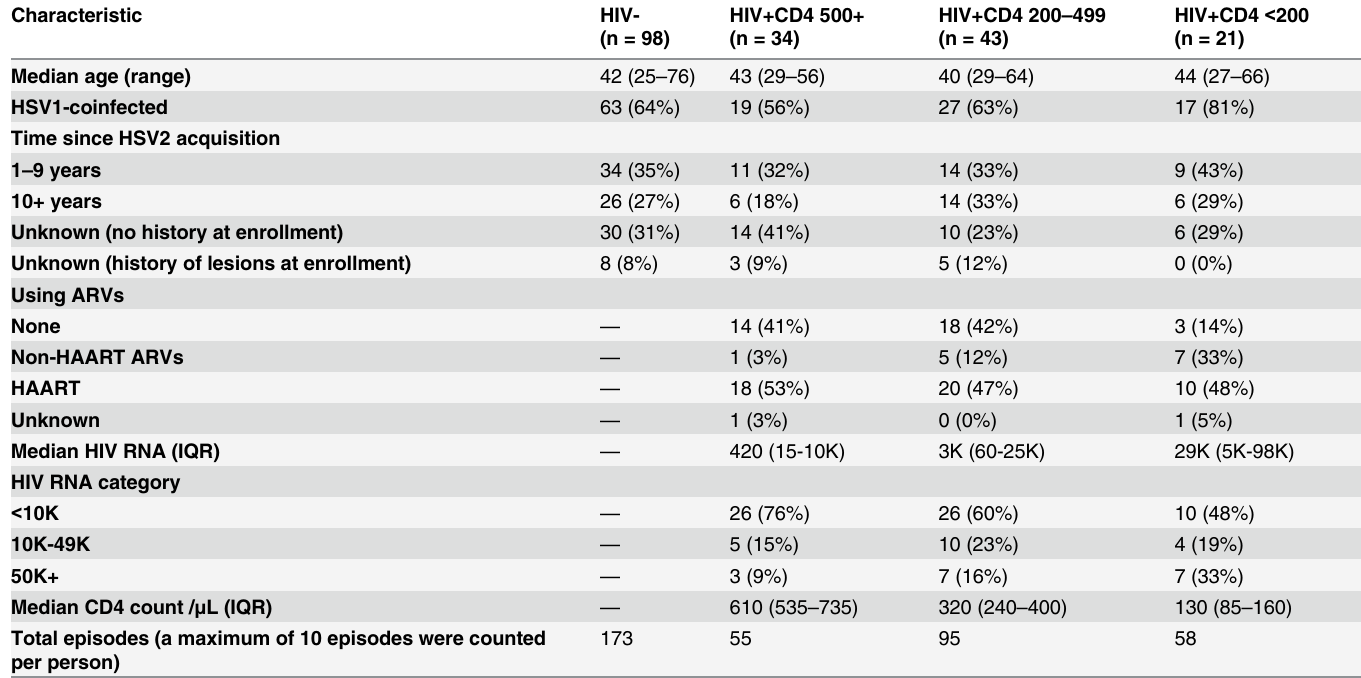
Table 1. Clinical cohort